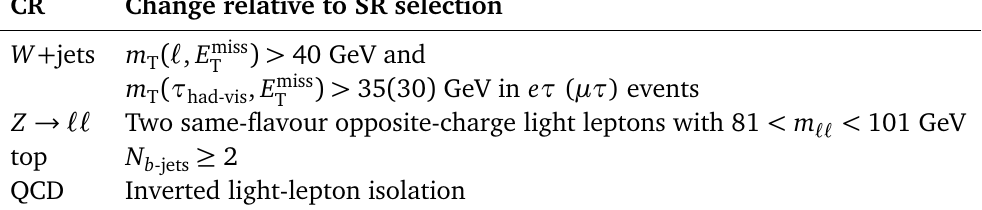
Table 1: Calibration regions used to derive fake factors. Differences from the SR selection are listed.